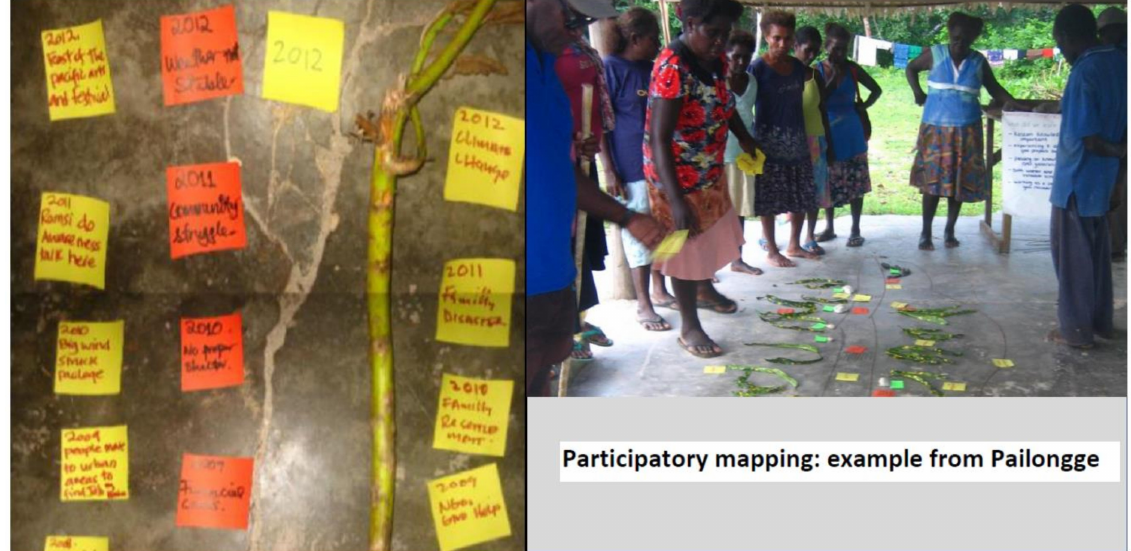
Figure 7. Examples of results from historical timeline exercises ( left ) and participatory mapping ( right ) in Pailongge. Participants identify key elements of villages and surrounding environments. These exercises were vital to the development of research methods with the communities, developing conversations over longer periods of time, and capturing essential data which documented the experiences of villagers. Timeline exercises document the order and sequence of events communities experienced from the onset of the disaster to the immediate and later impacts. Participatory mapping exercises involve community members mapping (in geographical and conceptual space) phenomena they consider to be important from the perspective of disaster vulnerability/resilience (e.g., water supplies, gardens, schools, churches, meeting